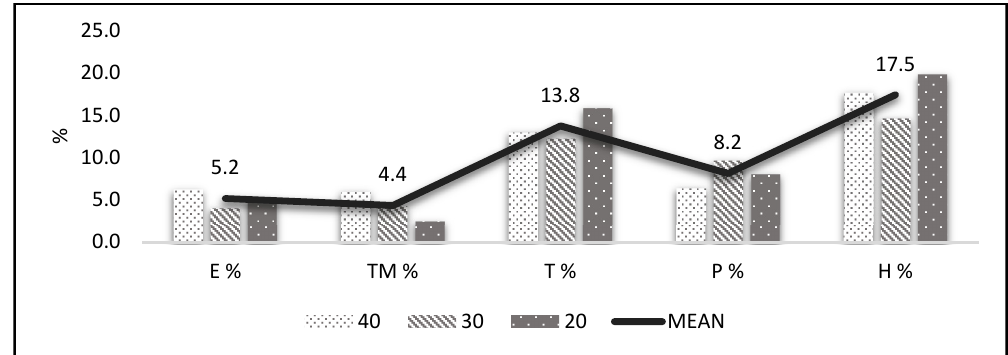
Figure 3. Contribution of meteorological parameters to ANN model accuracy.